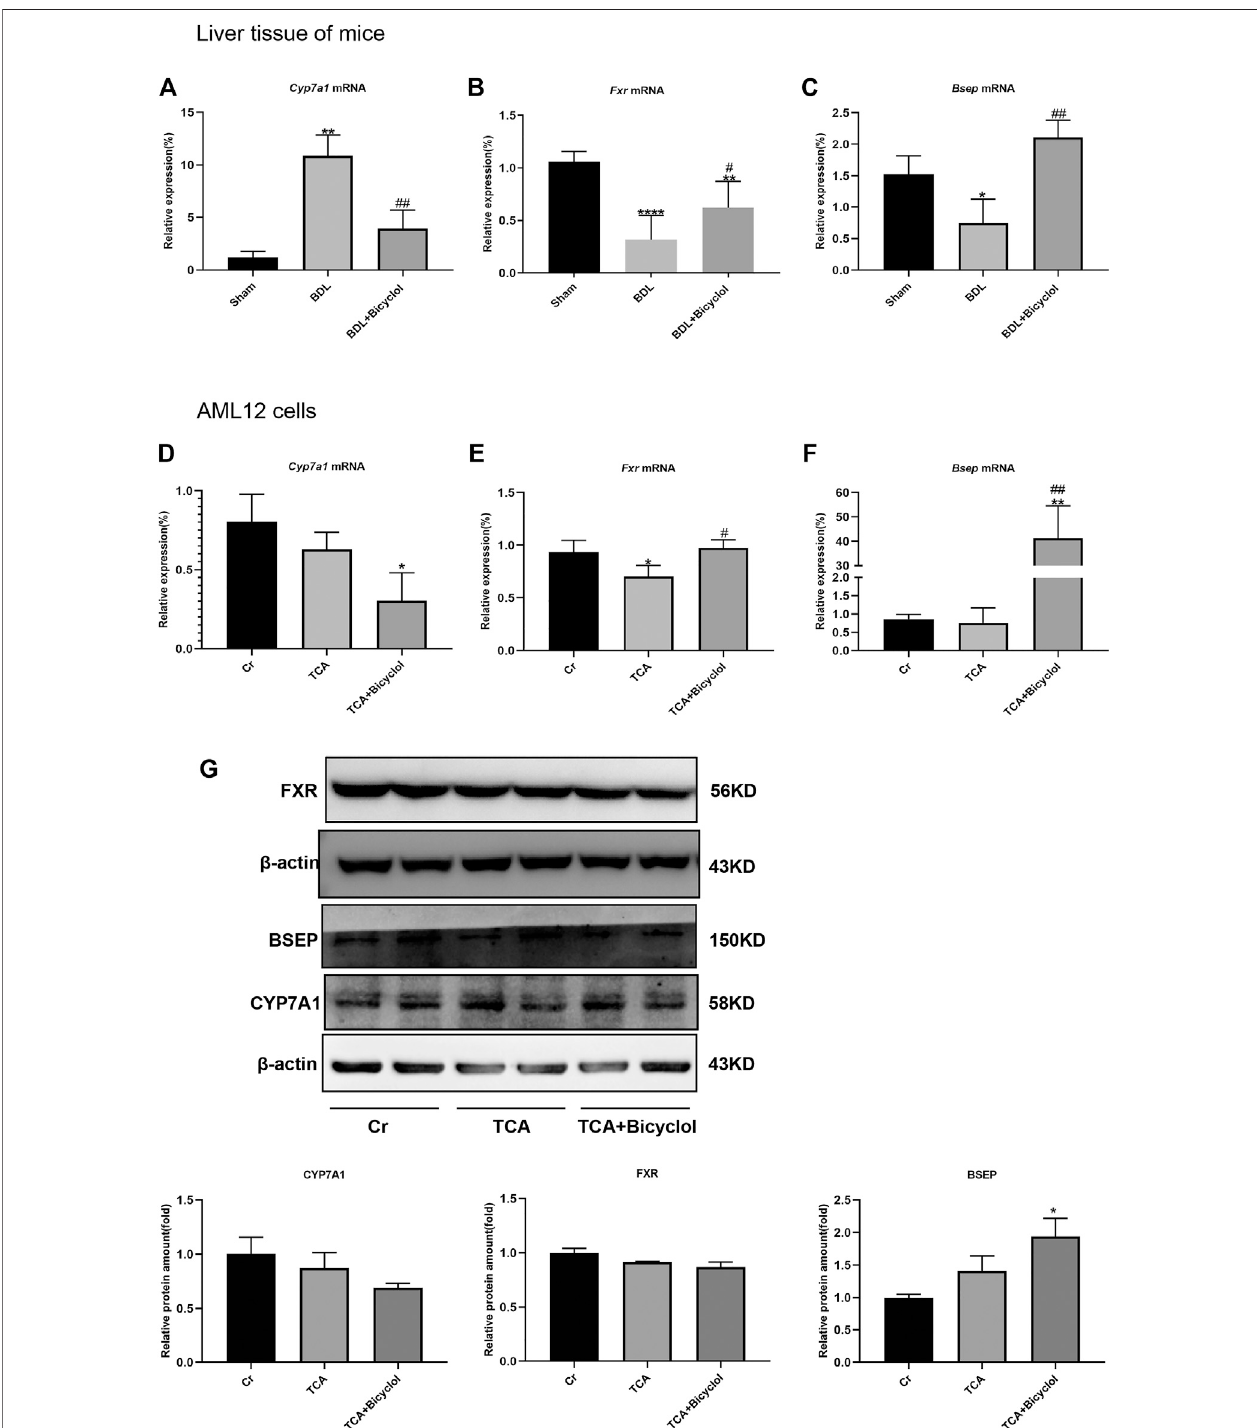
FIGURE 3 | Effects of bicyclol on genes related to bile metabolism. (A – C) The mRNA levels of bile metabolism-related genes (Fxr, Cyp7a1, Bsep) in BDL and bicyclol treatment mice. The mRNA levels (D – F) and protein levels (G) of bile metabolism-related genes (Fxr, Cyp7a1, Bsep) in AML12 cells after TCA and bicyclol exposure. Cr represents control group without special treatment, TCA means cells were stimulated with 100 uM TCA for 24 h, TCA + Bicyclol means cells were pretreated with 500 uM bicyclol for 2 h, then stimulated with 100 uM TCA for 24 h. Data are expressed as mean ± SD . *p < 0.05, ** p < 0.01, *** p < 0.001, **** p < 0.0001 vs. sham or Cr; # p < 0.05, ## p < 0.01 vs. BDL or TCA.